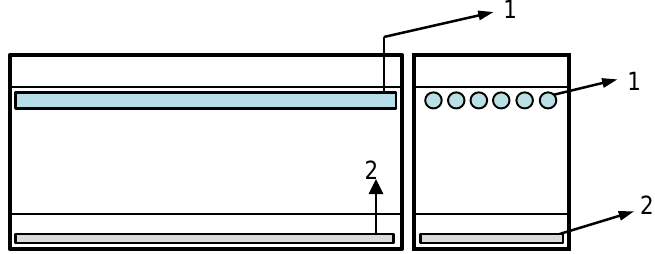
Figure 12. The diagram of the proposed photocatalytic reaction used in this work (1: CCFL visible light lamps, 2: immobilized ZnO catalyst mesh).